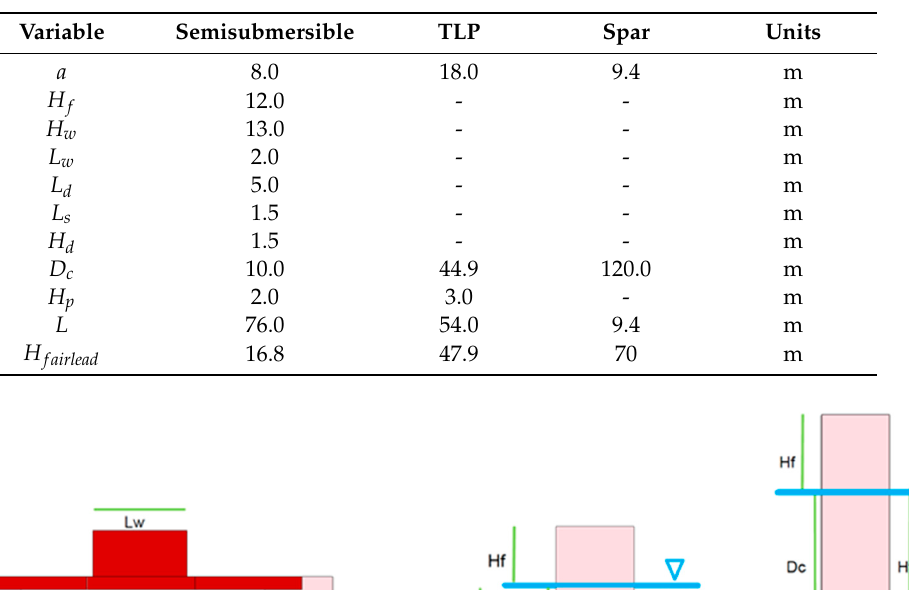
Table 1. Characteristics of the platforms [47].